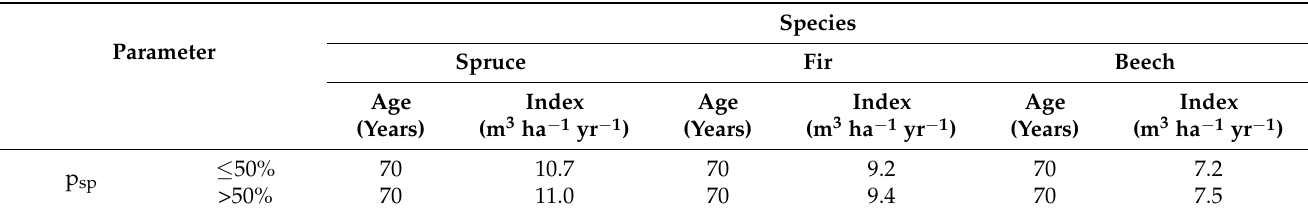
Table 6. Maximum MAIs.